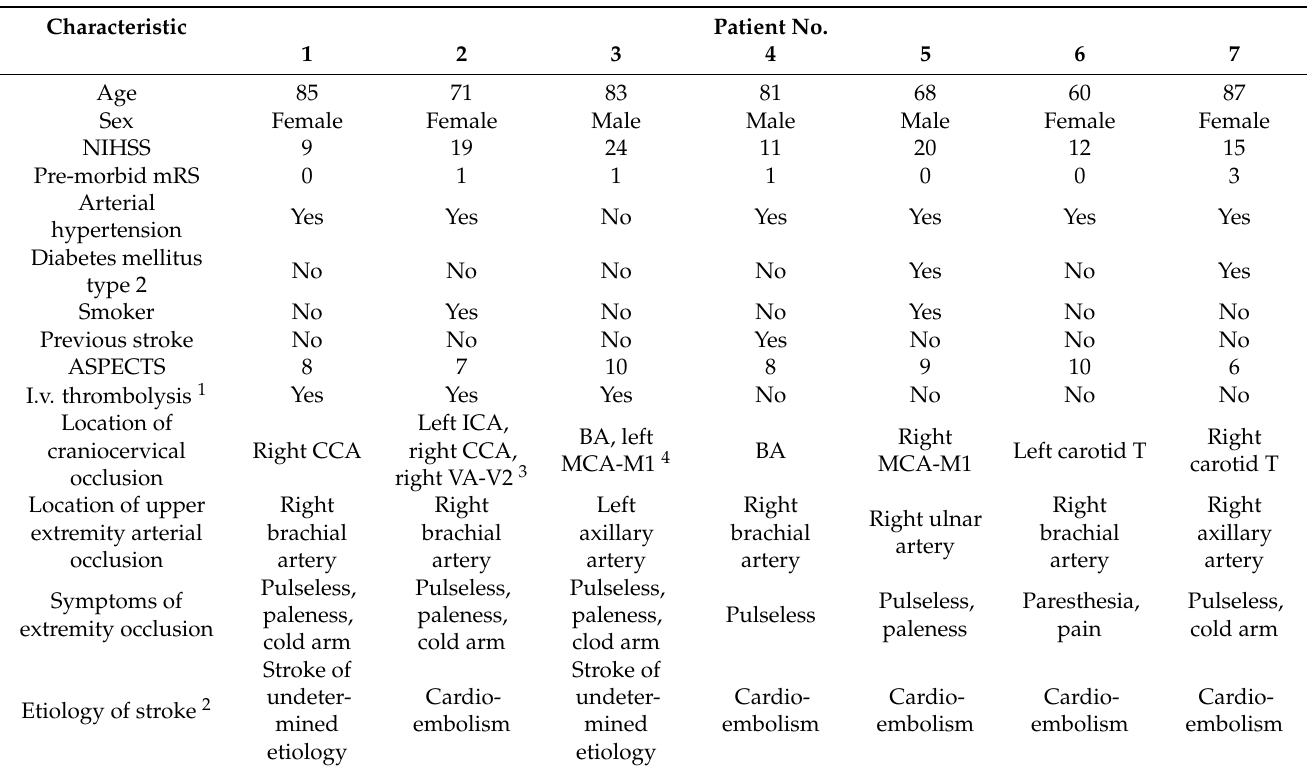
Table 1. Baseline characteristics.